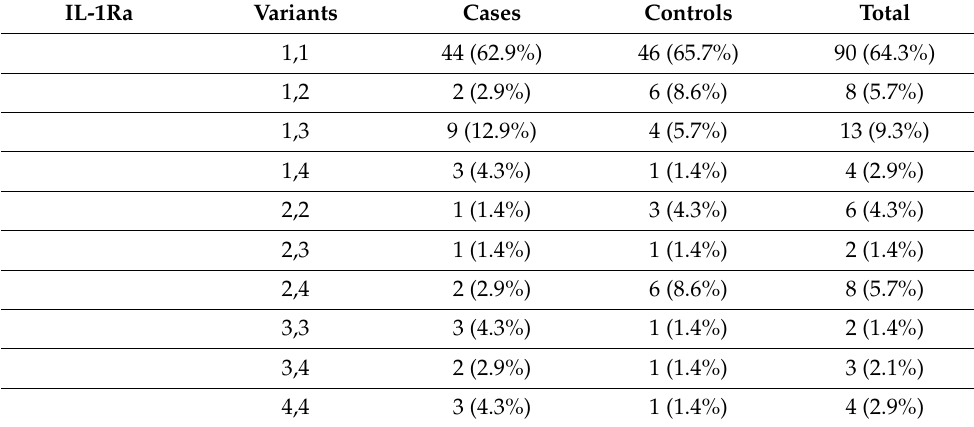
Table 4. Frequency of different IL-1Ra variants among patients with severe thrombocytopenia and control